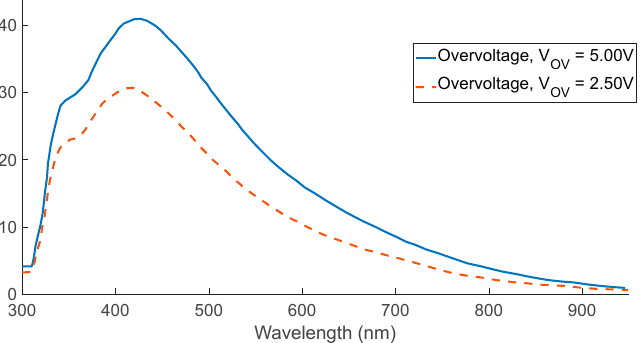
Figure 4. PDE versus wavelength for the OnSemi C ‐ Series, 3 mm × 3 mm, 35 μ m microcell size, for two different overvoltages. Reprinted with permission from ref. [50]. Semiconductor Components Industries, LLC., dba onsemi 2022.